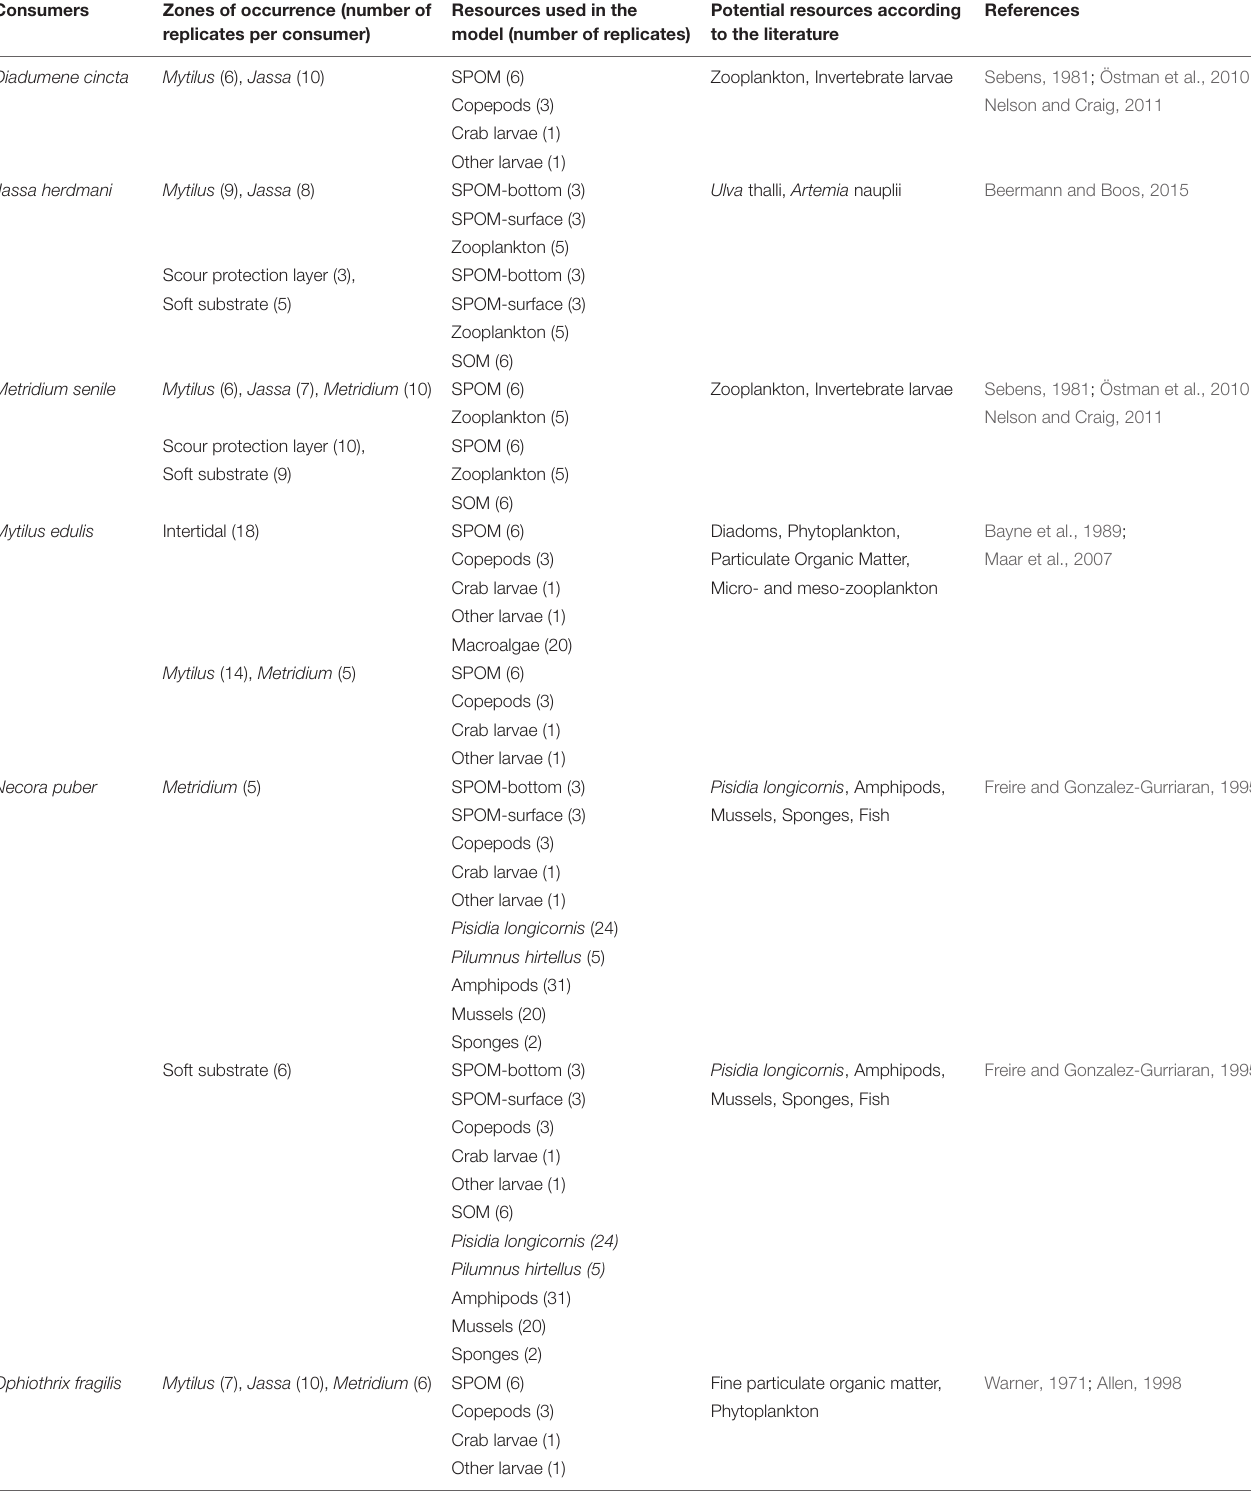
TABLE 1 | The seven dominant species (consumers) sampled in the different depth zones with the relative resources that were used in the mixing model per depth zone after the a posteriori combination of sources. Consumers Zones of occurrence (number of replicates per